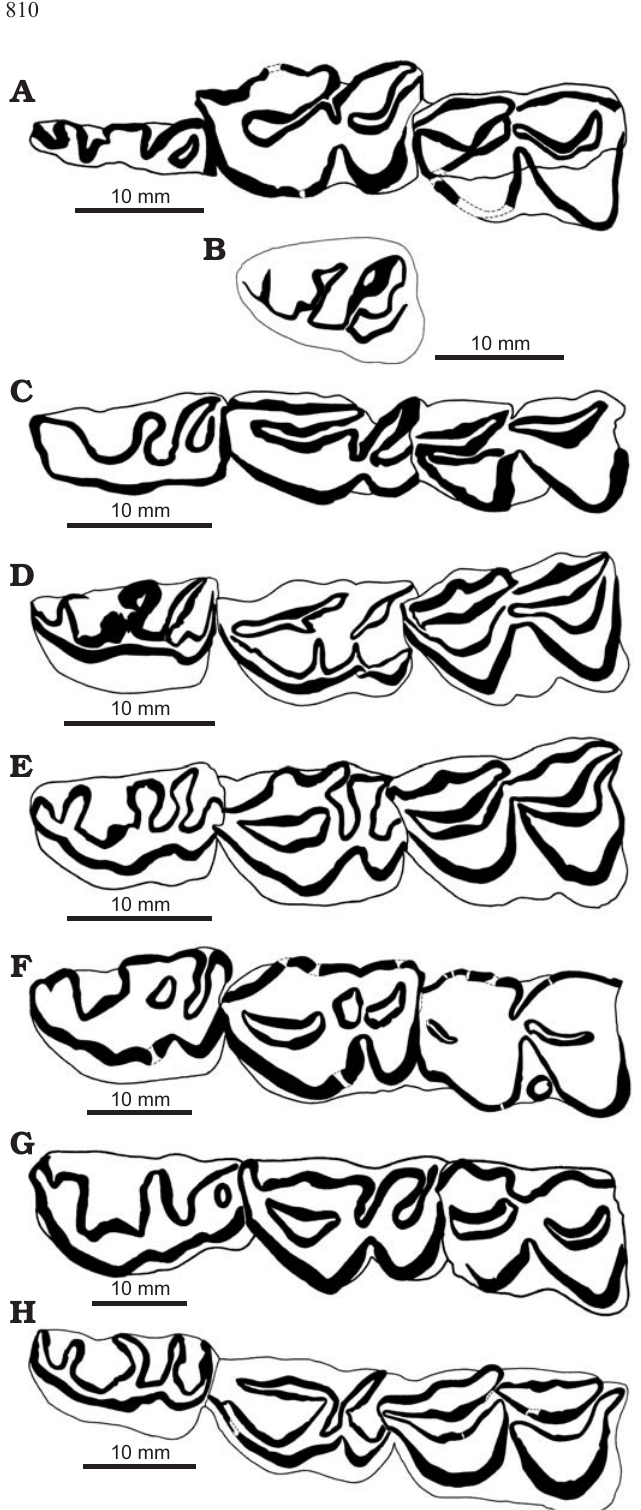
Fig. 4. Comparison of occlusal views of p3–m1 of the cervid mammal Capreolus constantini from the Pliocene of Hidalgo, Mexico, with selected extant cervids. A , B . Capreolus constantini . A . UAHMP 481. B . UAHMP